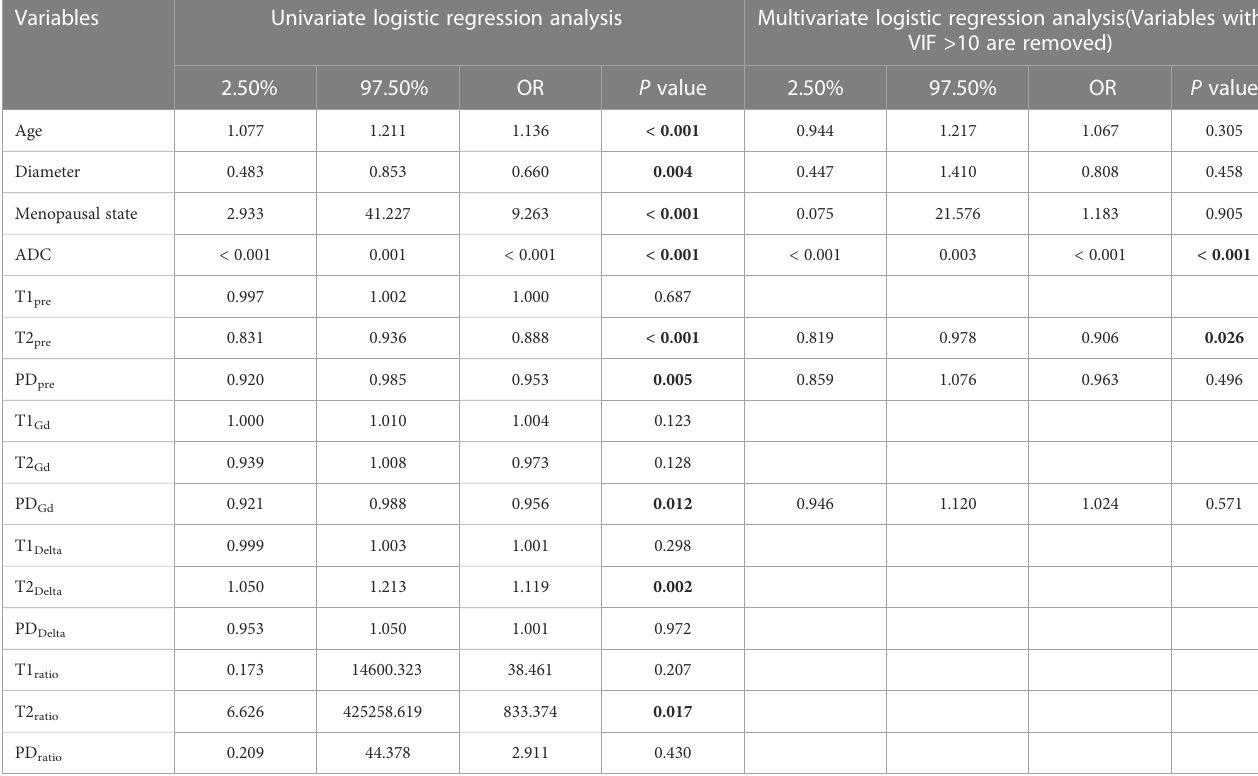
TABLE 3 Diagnostic value of parameters in univariate and multivariate regression analysis in the training group.